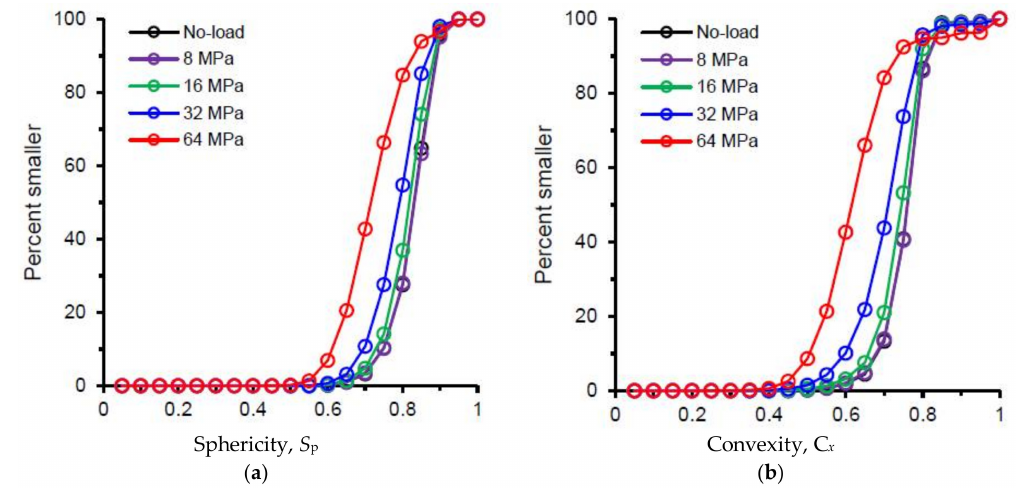
Figure 10. Distributions of shape parameters of RBS particles at different vertical stresses: ( a ) sphericity, ( b )